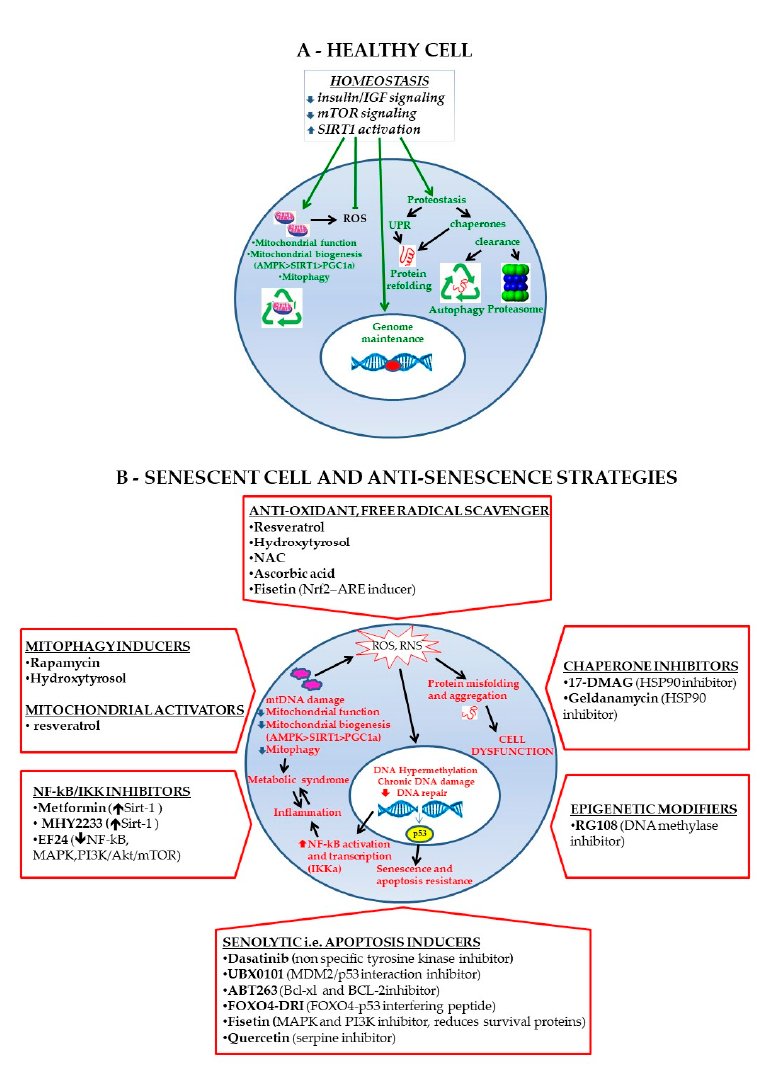
Figure 2. Failure of major homeostatic mechanisms contributes to senescence onset. Failure of major homeostatic mechanisms (autophagy, proteostasis and DNA damage repair networks and mitochondrial respiratory metabolism) in MSC is caused by aging or conditions that accelerate tissue aging, such as the obesity-associated systemic low-grade inflammation that impact on mitochondrial function. ( A ) Homeostasis is tightly controlled by the balance between the insulin/IGF_mTOR signaling and Sirt1. In conditions of homeostasis normal mitochondrial function, biogenesis and autophagy (mitophagy) guarantee that ROS level is kept to the minimum required for intracellular signaling. Both genomic and mitochondrial DNA are preserved from oxidative damage. Proteostasis is guaranteed by the correct functioning of the unfolded protein response (UPR) and clearance via autophagy or the ubiquitin-proteasome system. ( B ) Deranged metabolic factors together with aging contribute to mitochondrial dysfunction, accumulation of ROS (reactive oxygen species) and RNS (reactive nitrogen species) that increase the level of protein misfolding and aggregation, and impact on the integrity of both mitochondrial and genomic DNA. Accumulation of DNA damage cannot be e ffi ciently corrected because mitochondrial dysfunction leads to failure of the energy supply required by the DNA damage response. Persistent DNA damage is responsible for chronic NF- κ B activation and inflammation, leading to the “metabolic syndrome.” A positive feedback loop between metabolic syndrome and inflammation is even worsened by excessive ROS and RNS produced by the dysfunctional mitochondria. Persistent DNA damage is then responsible for p53 activation, with functional consequences for the cells that include cell cycle arrest, senescence, or apoptosis, according to an increasing degree. The “senescence pathway” depicted may be targeted for therapeutic intervention: the figure reports the major senotherapeutic classes acting at di ff erent functional levels as detailed in the text, although some molecules exert pleiotropic